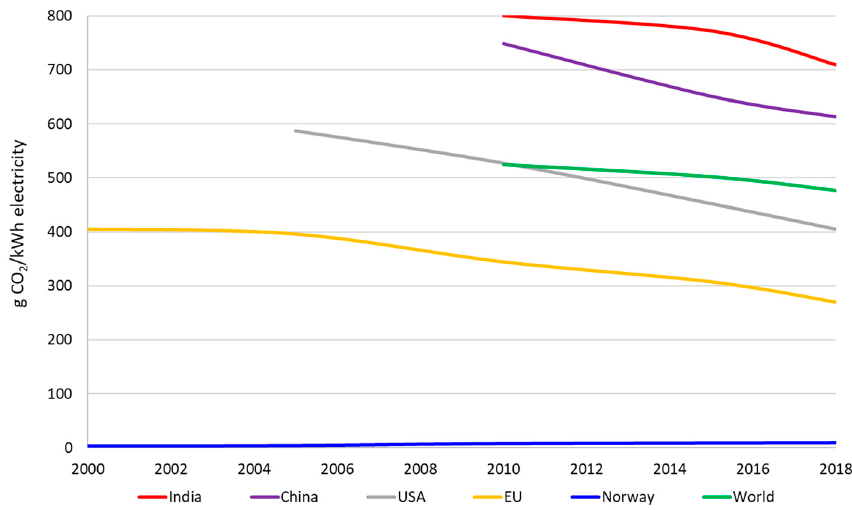
Figure 16. Development of specific CO 2 emissions of electricity generated in various countries and world-wide 2000–2018 [91,92].